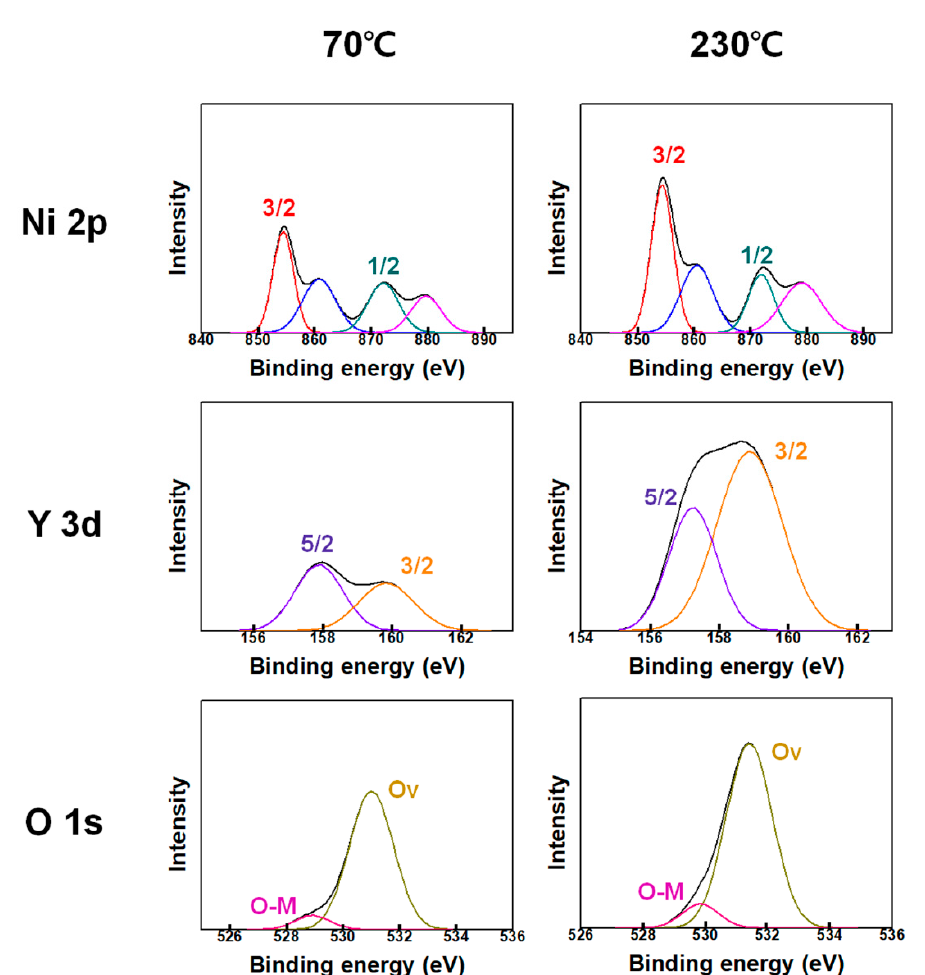
Figure 3. X-ray photoelectron spectroscopy results of Ni 2p, Y 3d, and O1s core levels obtained from brush-coated nickel yttrium oxide films which were cured at 70 and 230 °C.